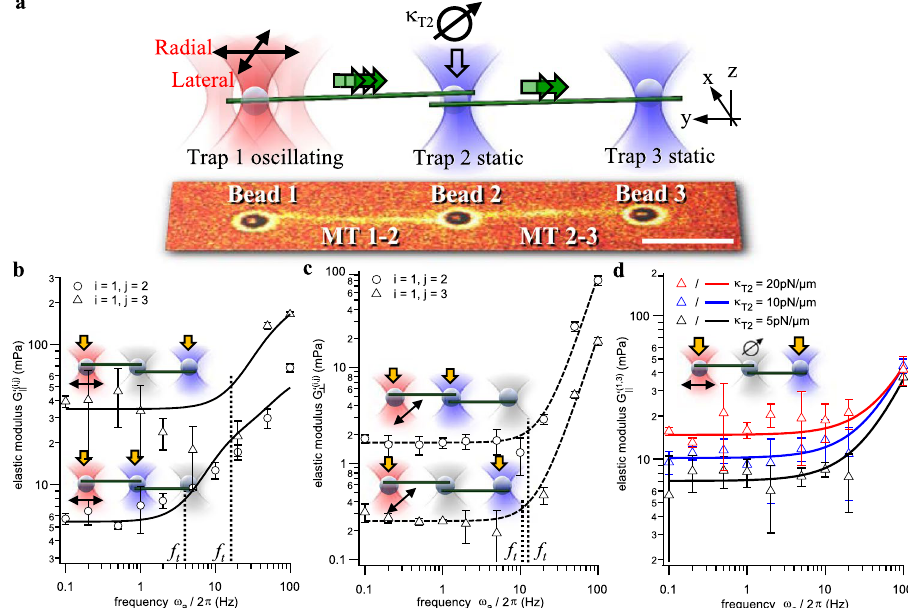
Figure 4. Rheology of a linear chain of connected filaments with transistor function. ( a ) Experimental design of linear network of two filaments held by three trapped beads. Bottom: overlay of fluorescence and brightfield image. Scale bar: 5 µ m. ( b ) and ( c ) Elastic components G ′ for a longitudinal and lateral MT end oscillation, i.e., in directions longitudinal or lateral to filaments, respectively. The transition frequencies are marked by black dotted lines. ( d ) Elastic components G ′ (1,3) for a longitudinal oscillation and different stiffnesses κ 2 of the intermediate optical trap. Error bars represent the standard deviation (SD) of N = 3 measurements